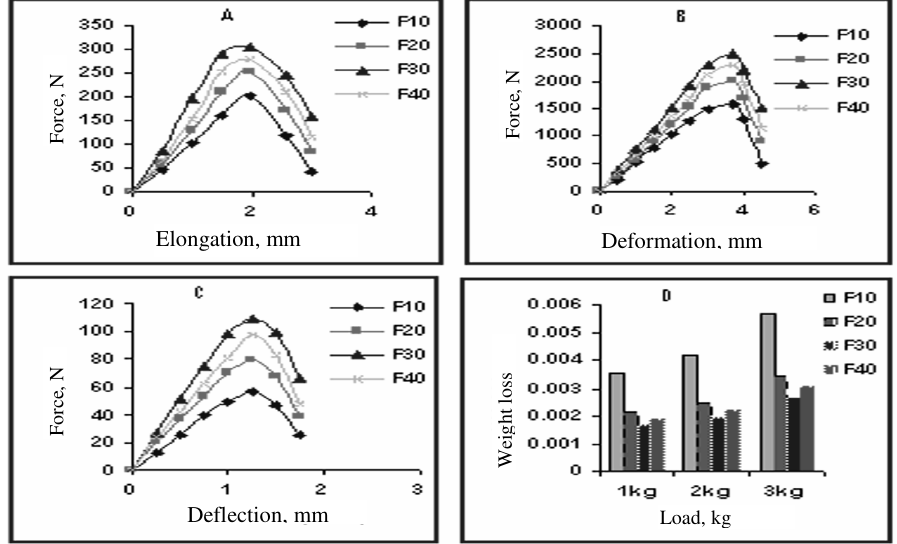
Figure 1. Load elongation/deformation/deflection & wear resistance curve of fiber reinforced composites (A, B, C,